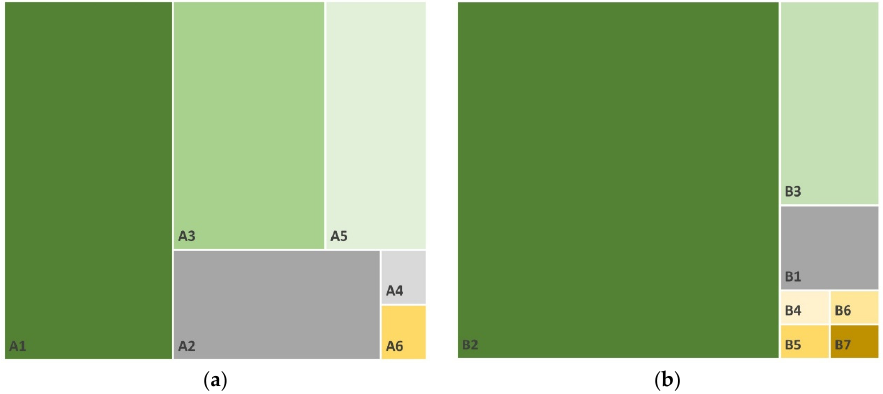
Figure 7. Classification and number of published articles according to ( a ) component/subsystem and ( b ) method.